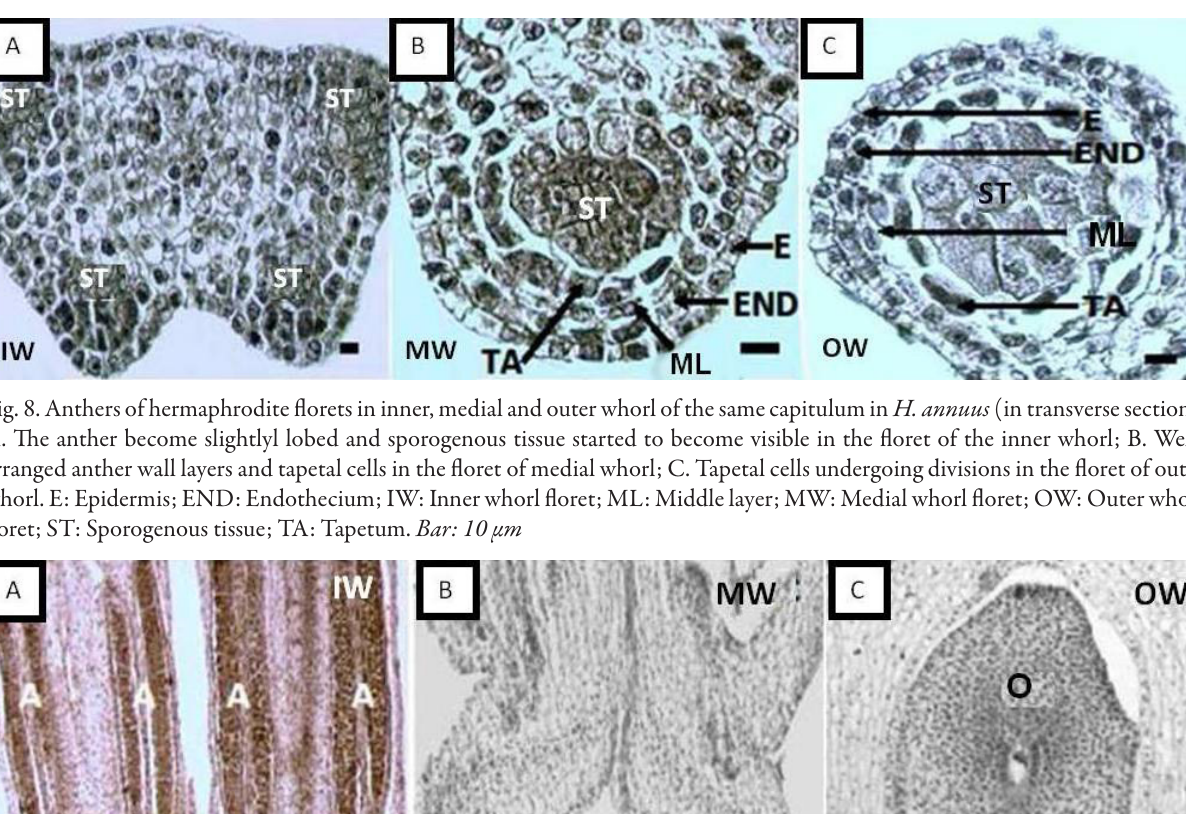
Fig. 7. Floret 1: stamen and carpel primordia become completely visible and ovarian cavity appeared, floret 2 and 3: stamen pri- mordia become completely visible; floret 4: apical meristem become completely visible on the same capitulum in H. annuus (in longitudinal section). AMS: Apical meristem; C: Carpel; FM: Floral meristem; IW: Inner whorl flower; OVC: Ovarian cavity; OW: Outer whorl flower; PET: Petal; S: Stamen; YL: Young leaves. Bar: 100 μm